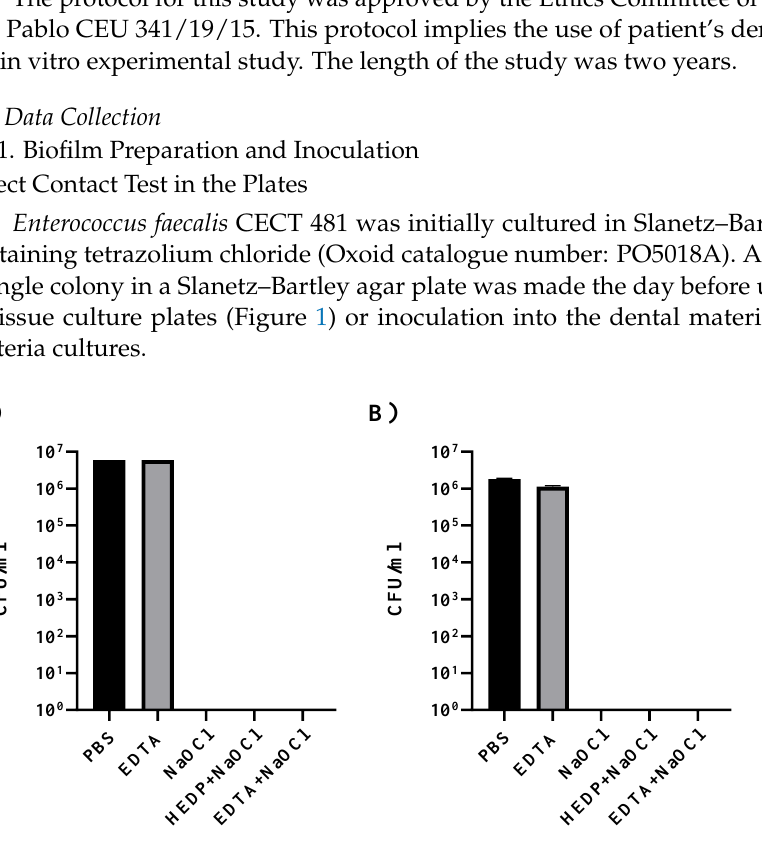
Figure 1. Effect of disinfecting irrigants against E. faecalis in vitro . Results of tests with irrigants against bacteria ( A ) and against bacteria forming mature biofilm ( B ). In both cases, no bacteria were detected in treatments using irrigants with NaOCl.